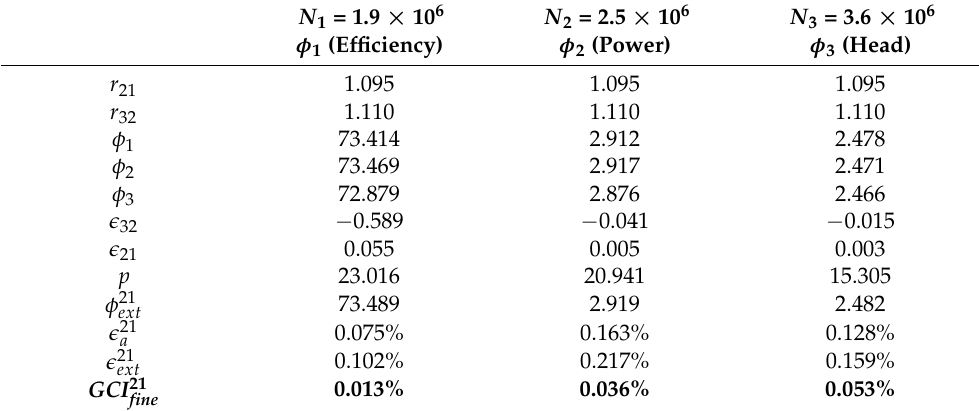
Figure 9. Grid dependency test for SCP model.